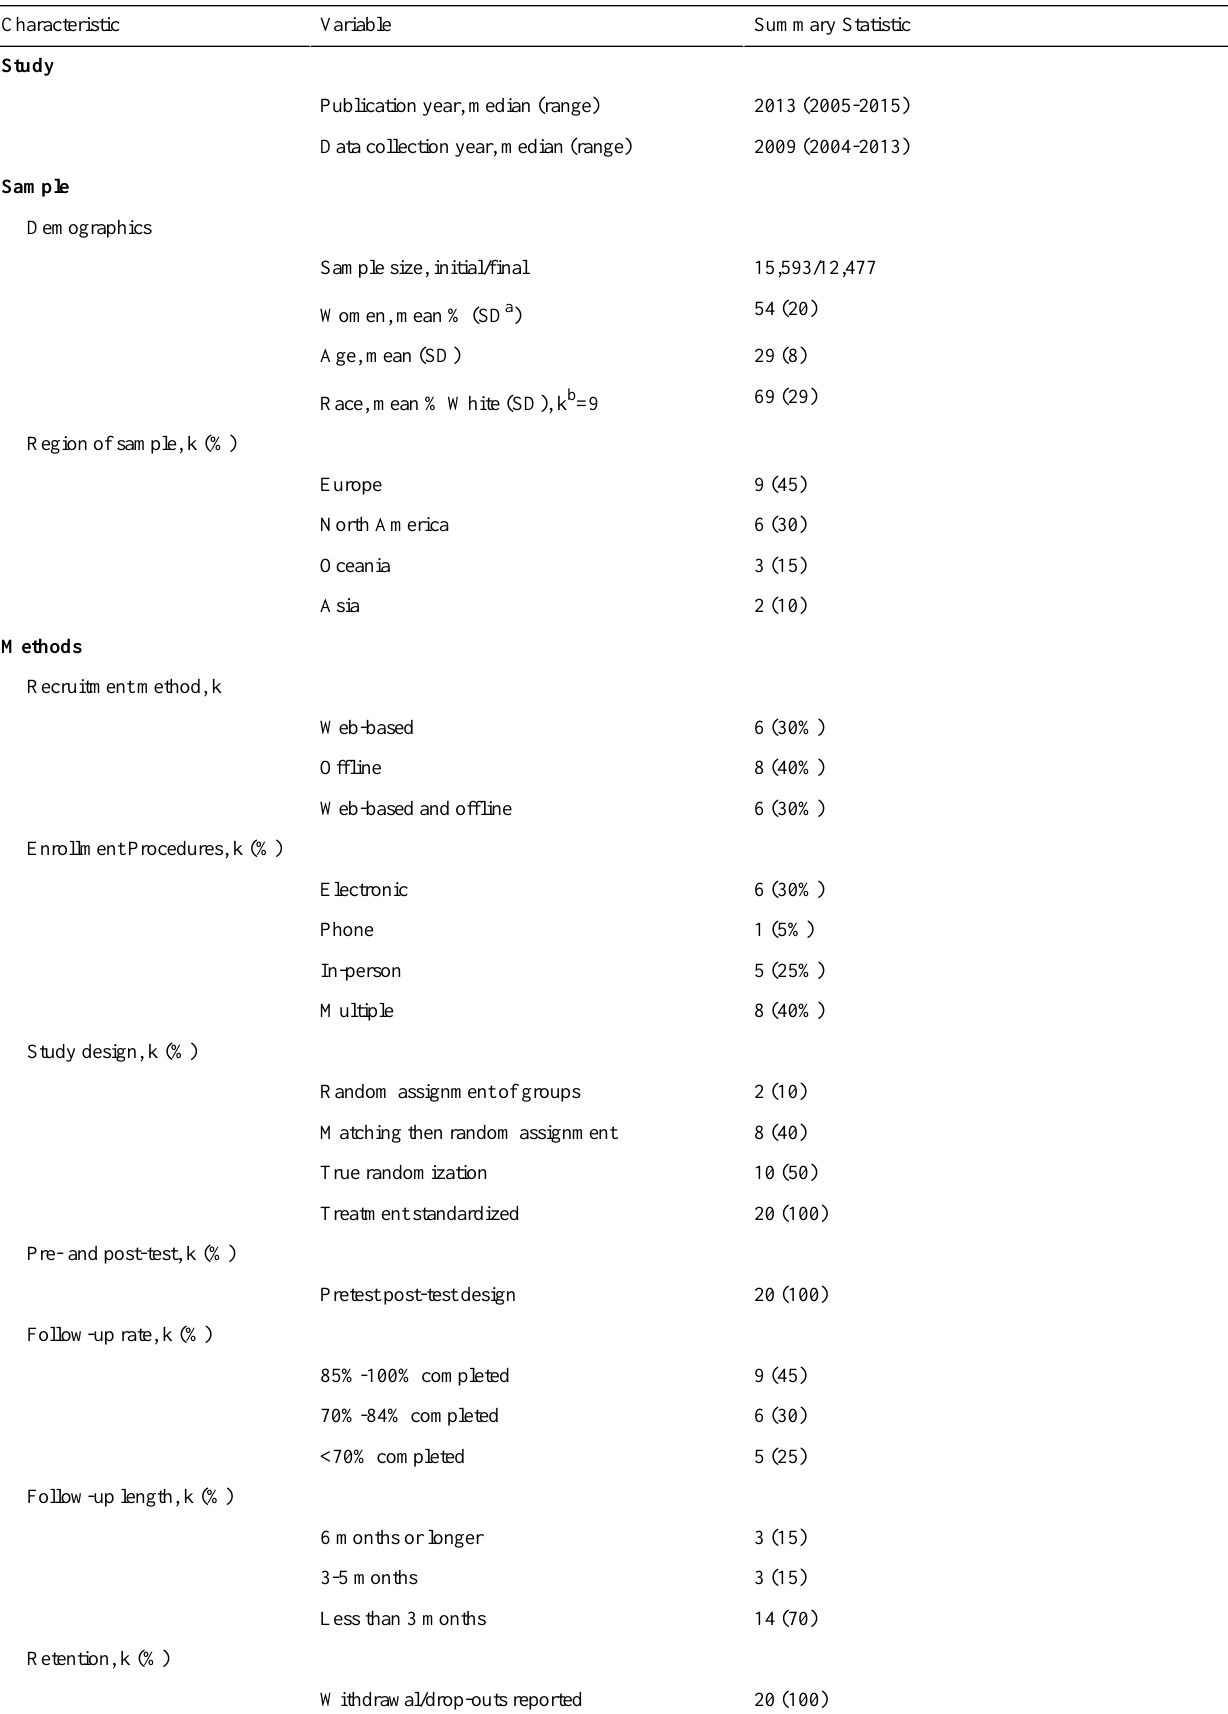
Table 2. Description of study, sample, and intervention characteristics of 20 included studies.